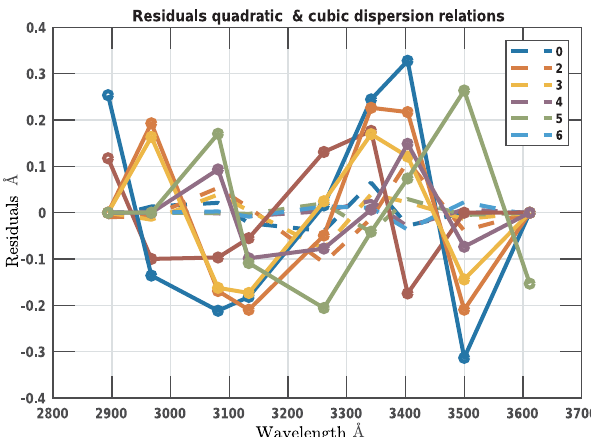
Figure 8. Residuals of the quadratic (filled circles, solid lines) and cubic (dashed lines) fits. The colour indicates the six Brewer slits with the laser wavelengths in equally spaced grid every